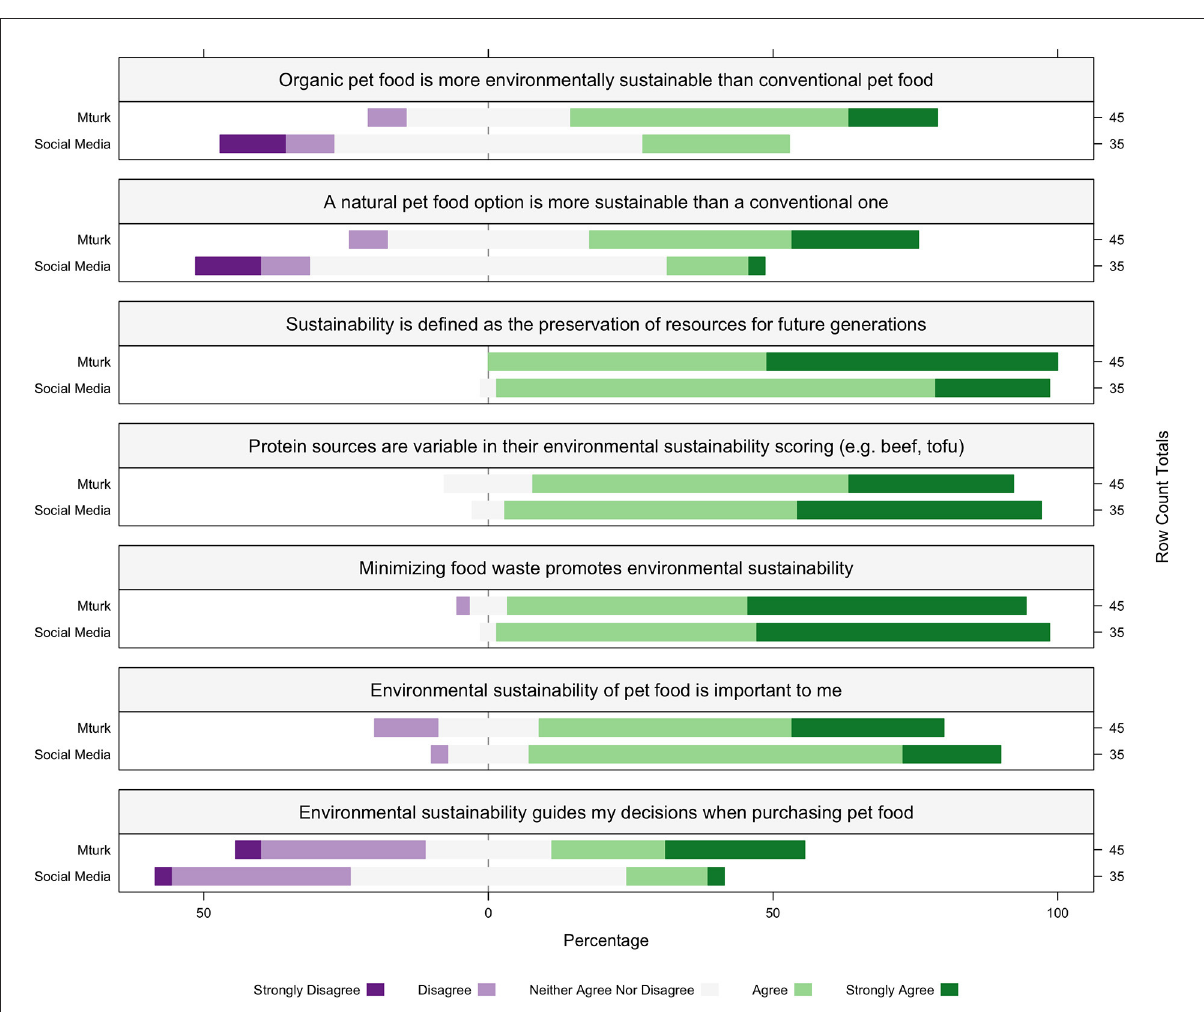
FIGURE3 The percentage within each recruitment source MTurk (MT; n = 45) and social media (SM; n = 35) of consumer agreement with environmental sustainability statements. Participants reported to “Strongly Disagree,” “Disagree,” “Neither agree Nor Disagree,” “Agree,” or “Strongly Agree” to each attitude toward sustainability statements listed in the box above each corresponding plot. The percentage of participants within each recruitment source is represented on the x-axis, the recruitment source is represented on the left y-axis, and the row count totals (the number of participants for each question within each recruitment source) are listed on the right y-axis for each